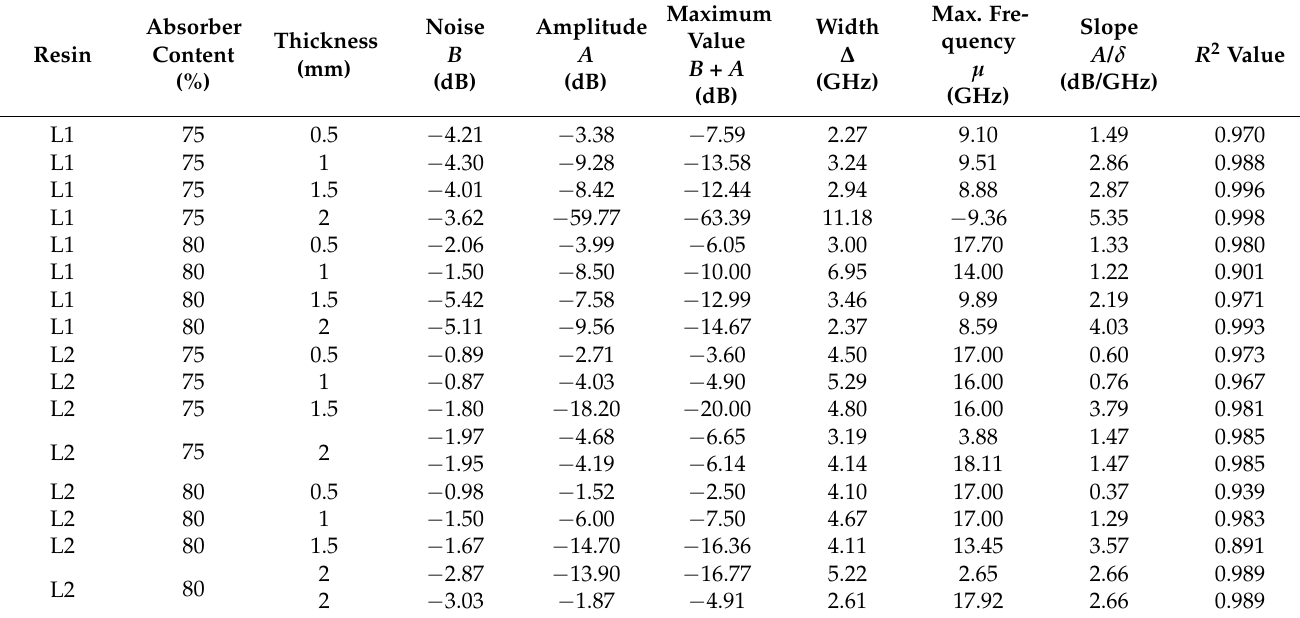
Table 4. Results of fitting the model curve (Gaussian) to the measurement results.